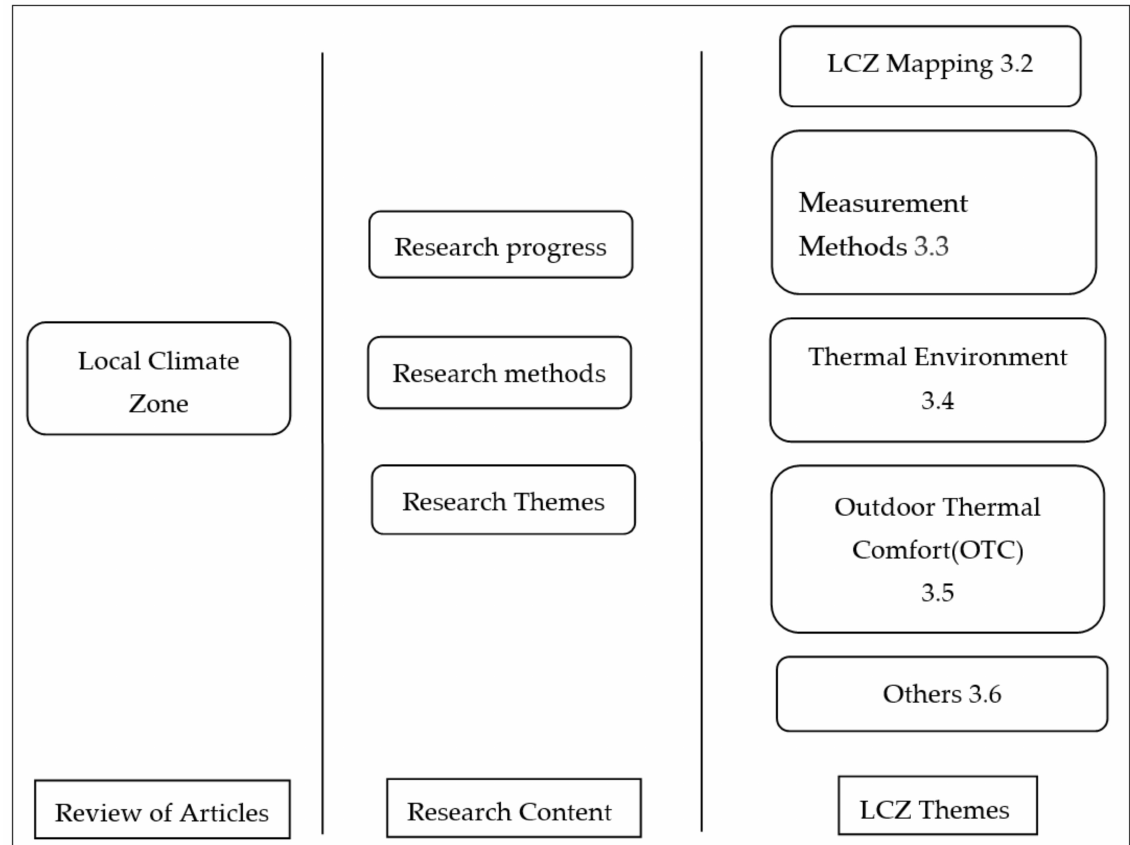
Figure 3. Research themes related to